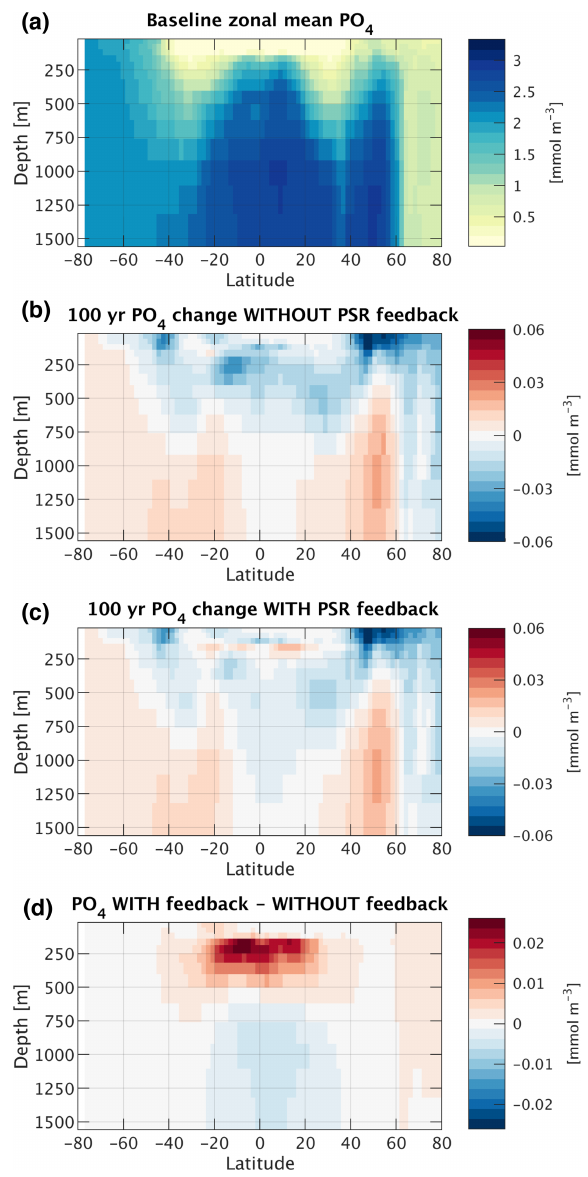
Figure 8. (a) Baseline (current-day circulation, ran to steady state) zonal mean phosphate concentration. (b) Absolute change in zonal mean phosphate concentration 100 years after decreasing circula- tion rates by 10% with the PSR feedback turned off. (c) Same as (b) but with the PSR feedback turned on. (d) Difference in zonal mean phosphate concentration between PSR feedback-on and feedback- off runs (i.e., b minus c